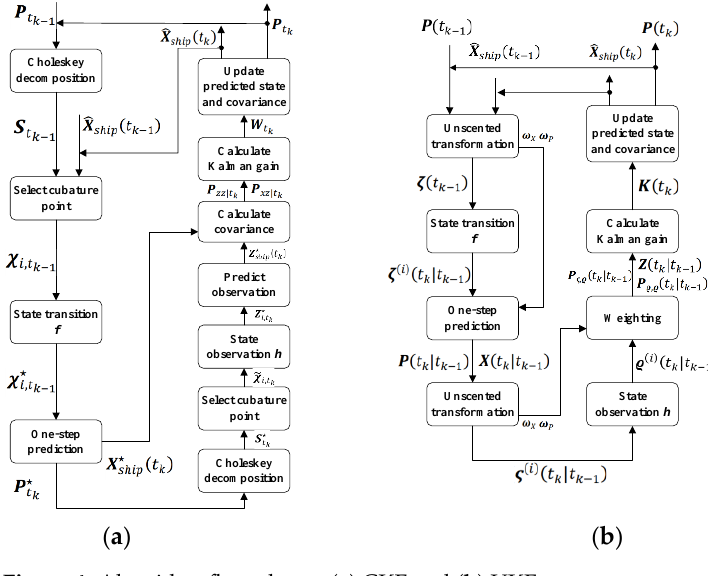
Figure 4. Algorithm flow charts: ( a ) CKF and ( b ) UKF.